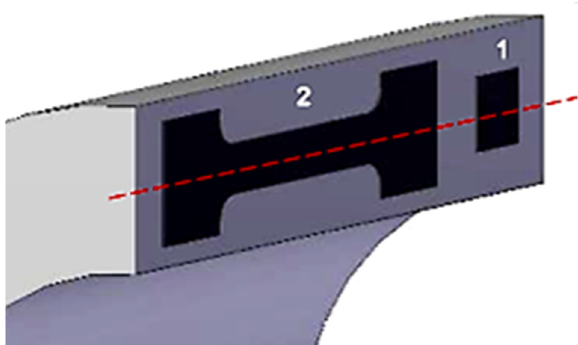
Figure 2. Specimens for the permeation tests: (1) In the absence of load; (2) Under cyclic loading.